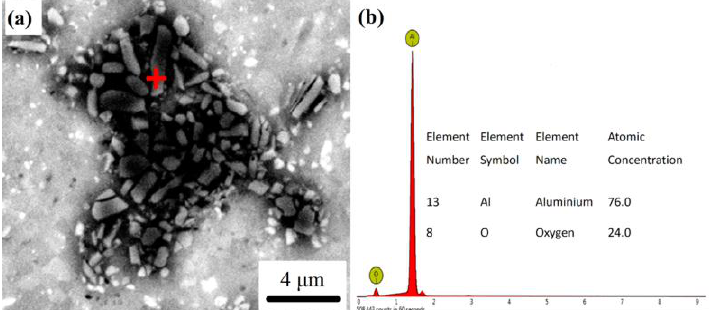
Figure 1. Scanning Electron Microscopy (SEM) images of hot extruded Al-12Si/Al 2 O 3 nanocomposites with ( a ) 0, ( b ) 2, ( c ) 5, and ( d ) 10 wt. % reinforcement.